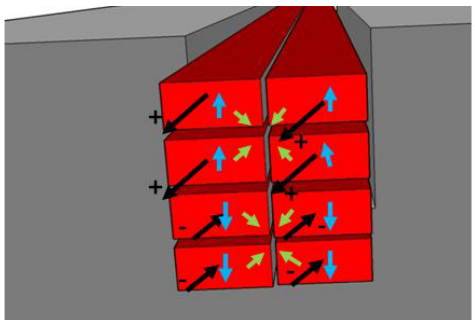
Figure 27. In this figure, a slot contains eight strands. They are divided into two groups. The four upper strands carry a current oriented +, the four other strands carry a current oriented in the opposite (-). In each strand, two types of forces exist. The first one, in green, is the force induced by the strands of the same group (It gathers the strands). In blue, the force induced by the strands of one group to the strands of the other group (The groups repulse